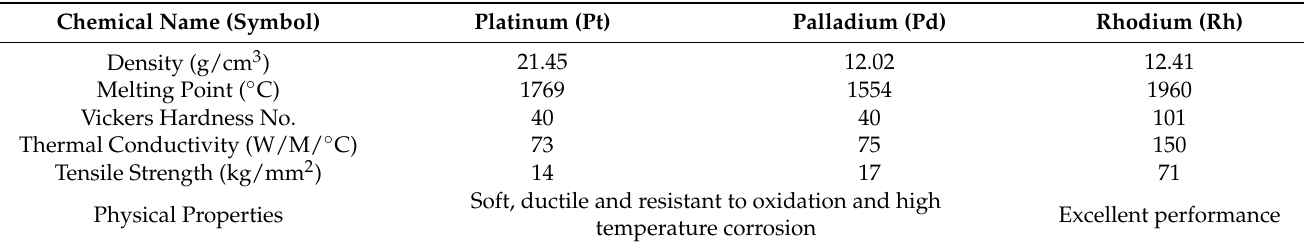
Table 1. Chemical and physical properties of PGM metals. Adapted from [42].